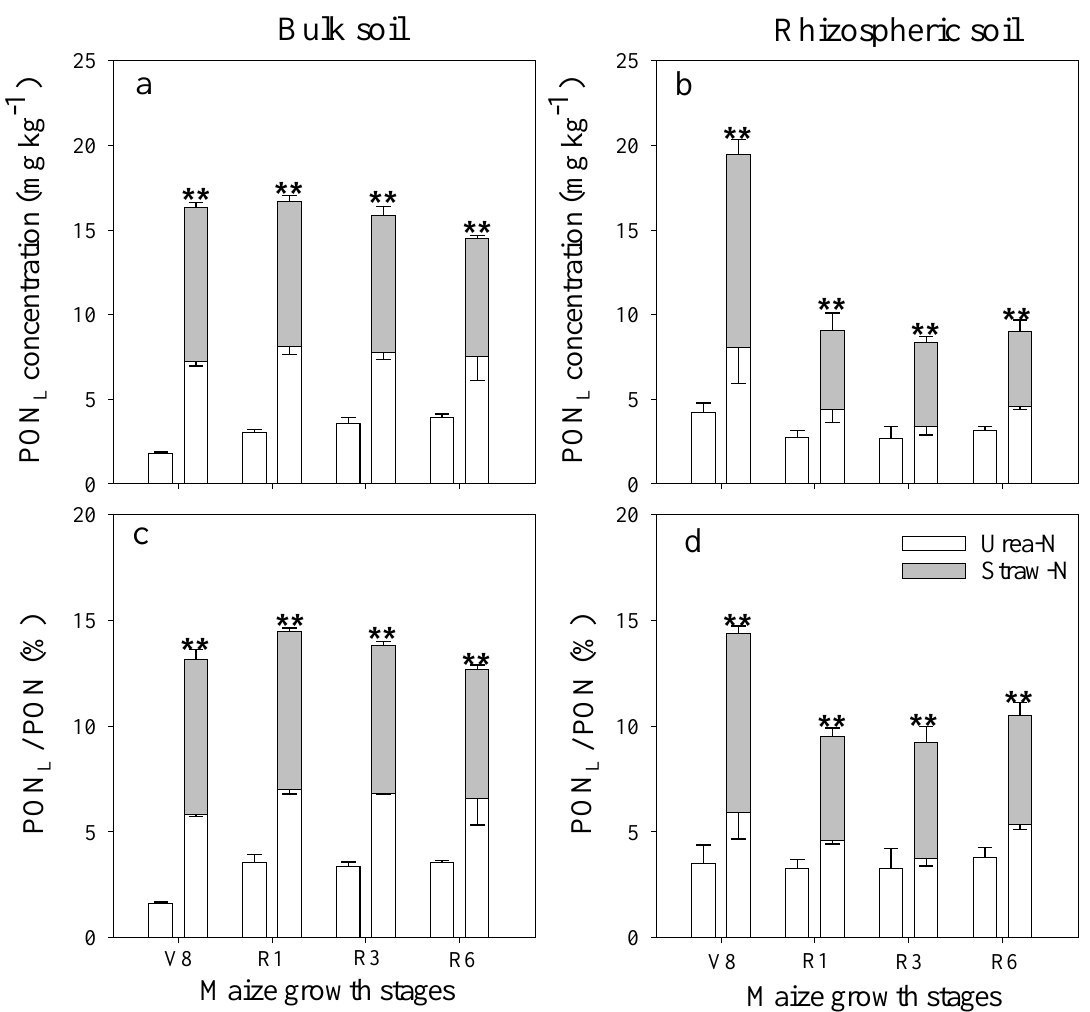
Figure 7. Concentration ( a , b ) and percentage ( c , d ) of labeled applied N (N L ) present as particulate organic N (PON) in bulk and rhizosphere soil in different fertilizer treatment during maize growth. White-only bars represent urea treatment (U). White plus gray bars represent urea combined with straw treatment (US). Maize growth stage: V8, R1, R3, and R6 respectively represent 8th leaf stage, silking stage, milk stage, and physiological maturity. Data shown are mean ± standard deviation of three replicates; ** denote significant differences at p < 0.01.